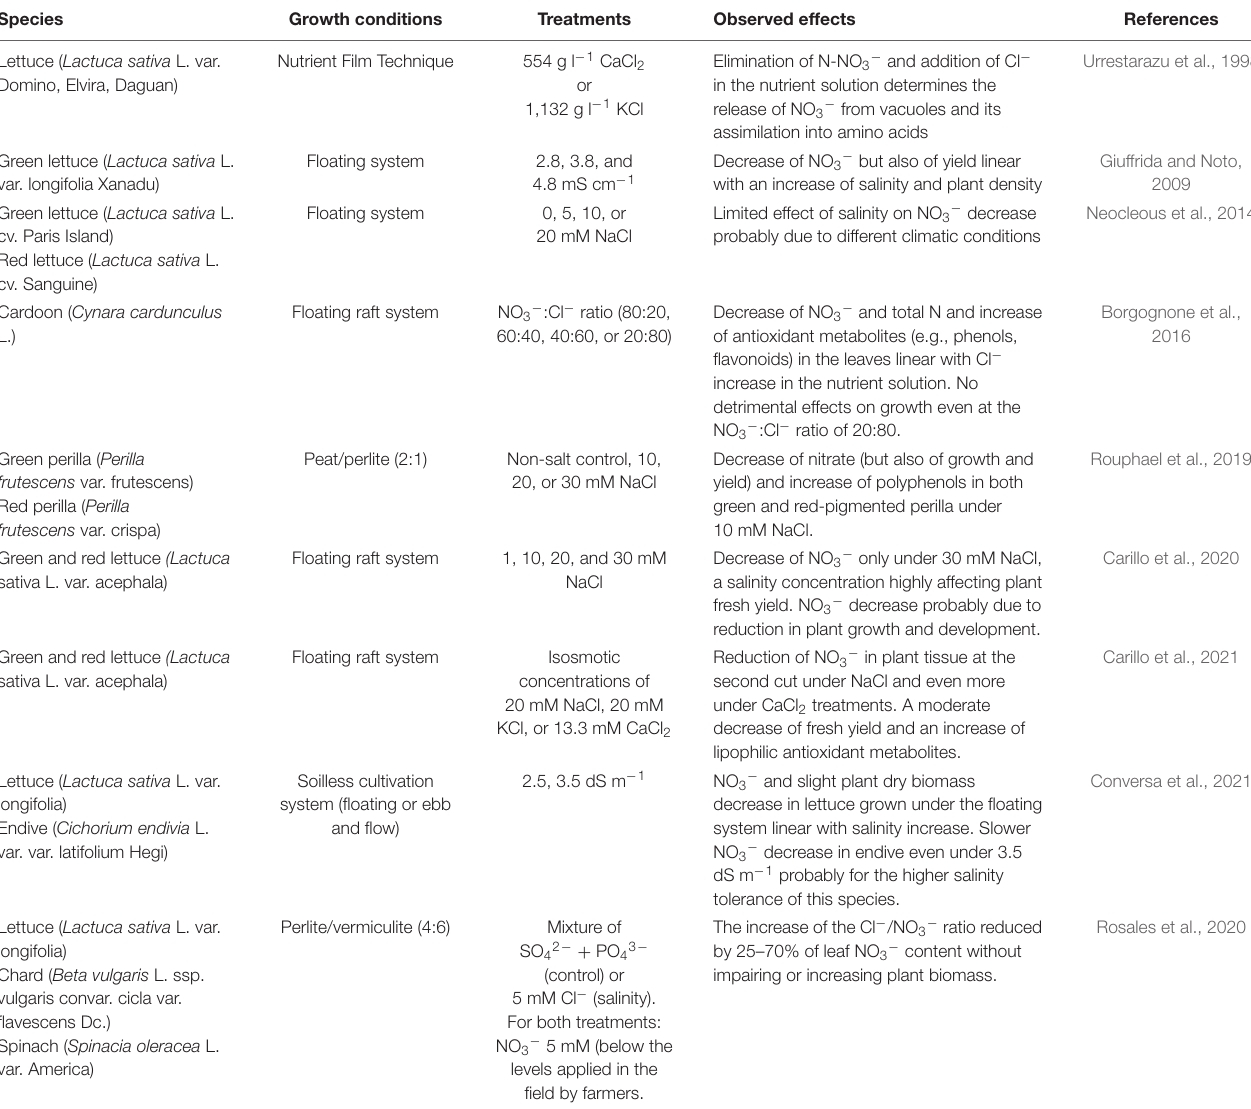
TABLE 2 | Application of Cl − eustress for reducing NO 3 − accumulation in leafy